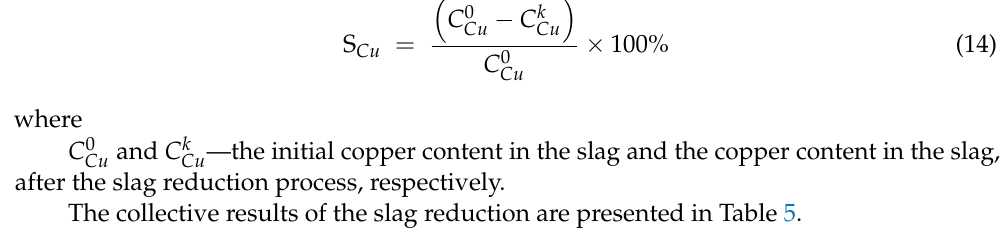
Table 5. Results of slag copper removal